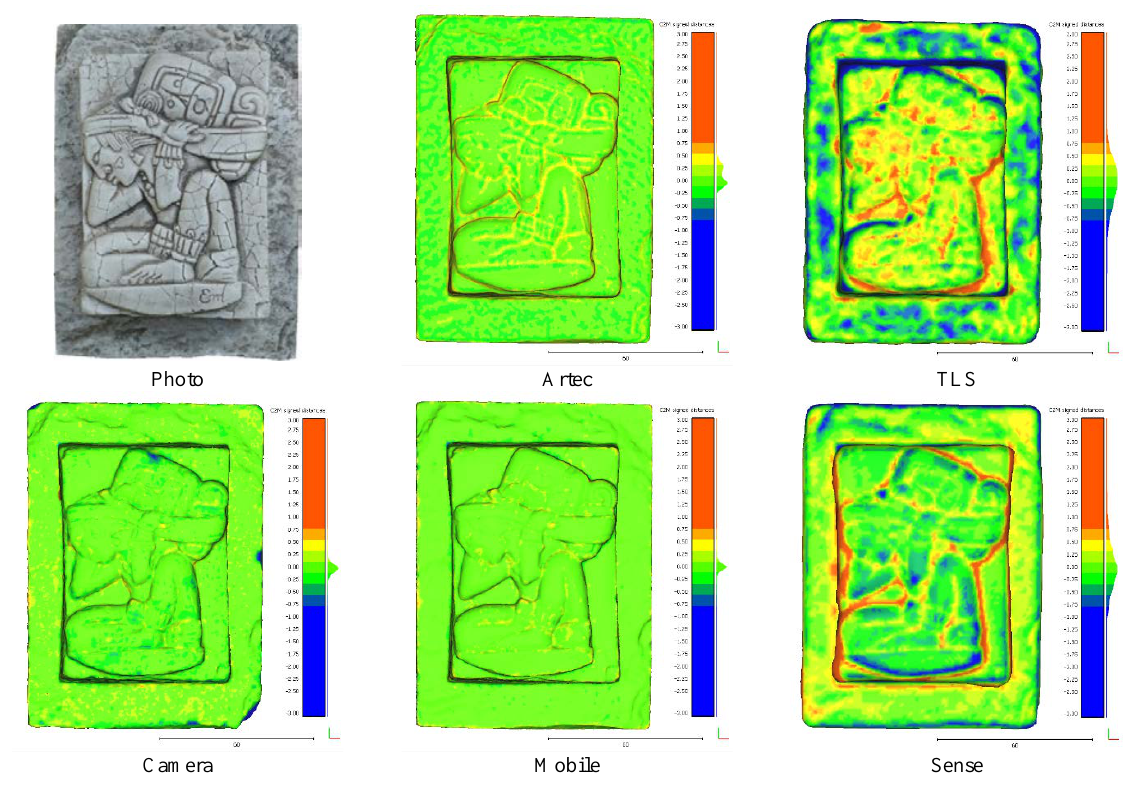
Figure 4. Deviation maps of the surface models compared to the